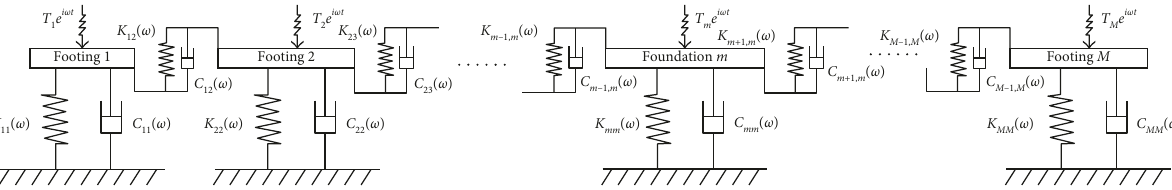
Figure 2: Equivalent model in frequency domain for dynamic interaction of footing group with frequency-dependent springs and dampers.